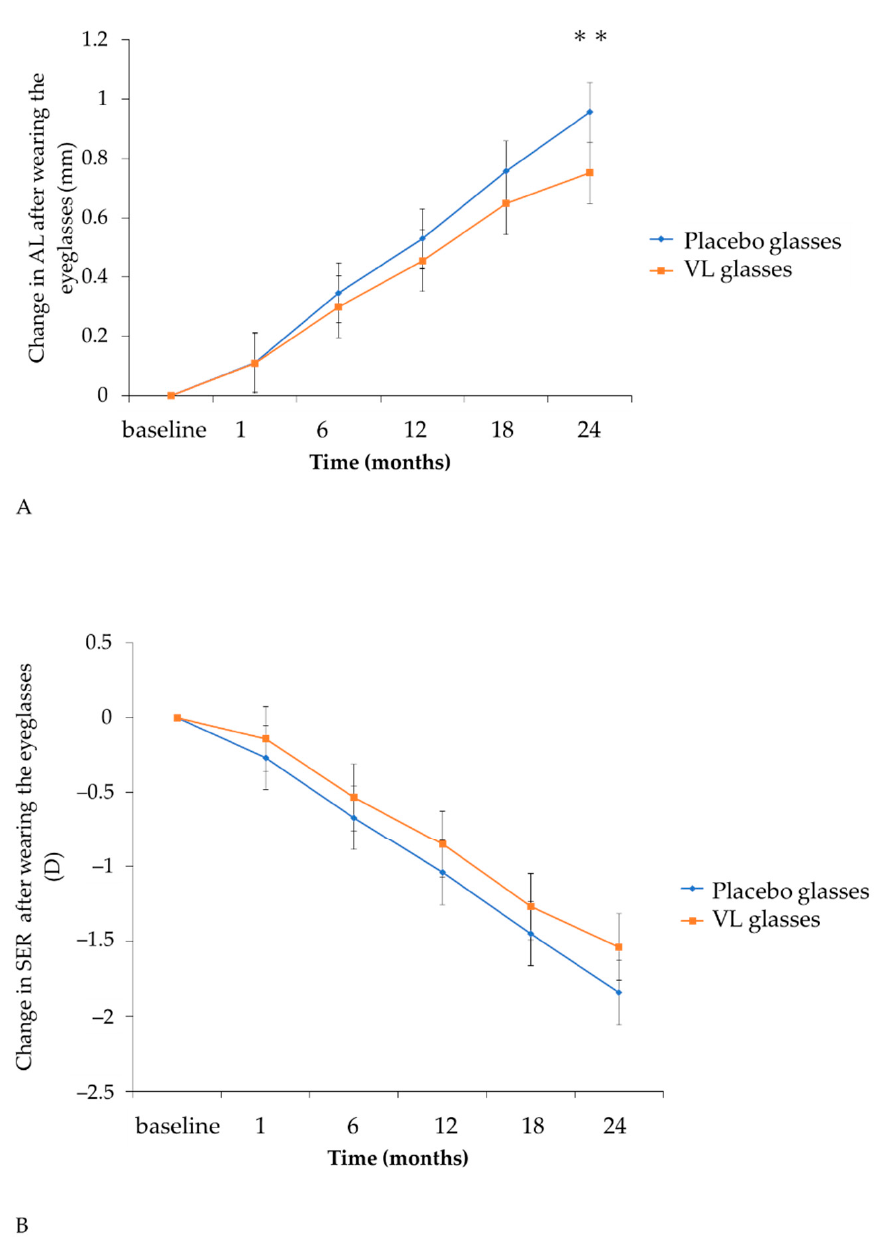
Figure 3. Time course of the adjusted mean axial elongation and SER change under the limited condition in which near-work time was less than 180 min and there was no previous history of eyeglasses use. ( A ) change in AL after wearing the eyeglasses, ( B ) change in SER after wearing the eyeglasses. AL: axial length, SER: spherical equivalent refraction ** p < 0.01.